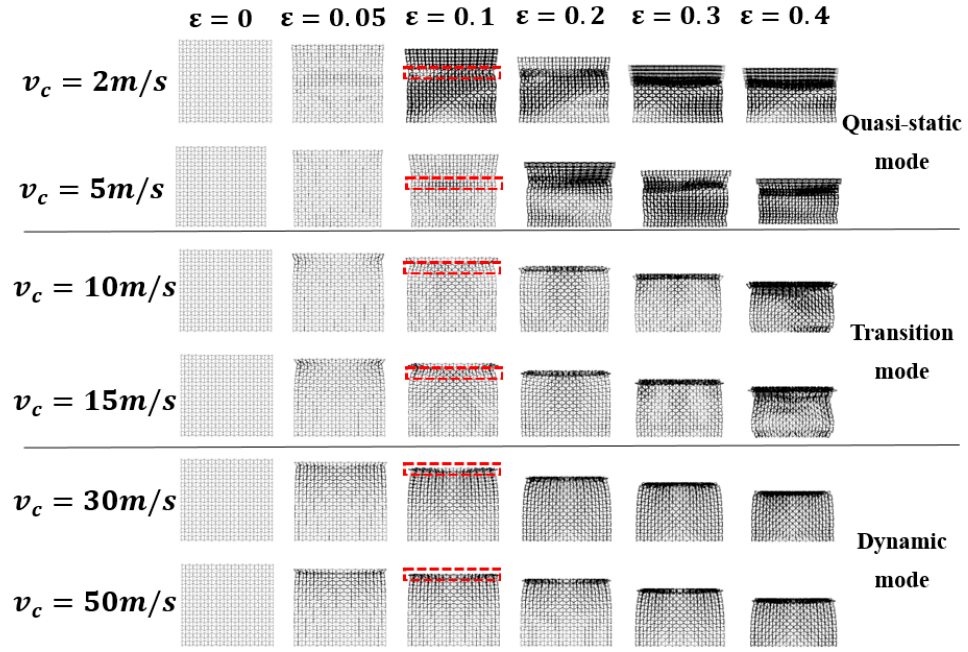
Figure 7. Deformation processes of the3D re-entrant auxetic structure ( ρ R = 1%) under different crushing velocities.